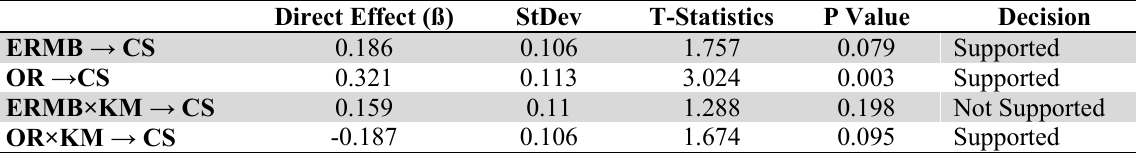
Path Coefficient